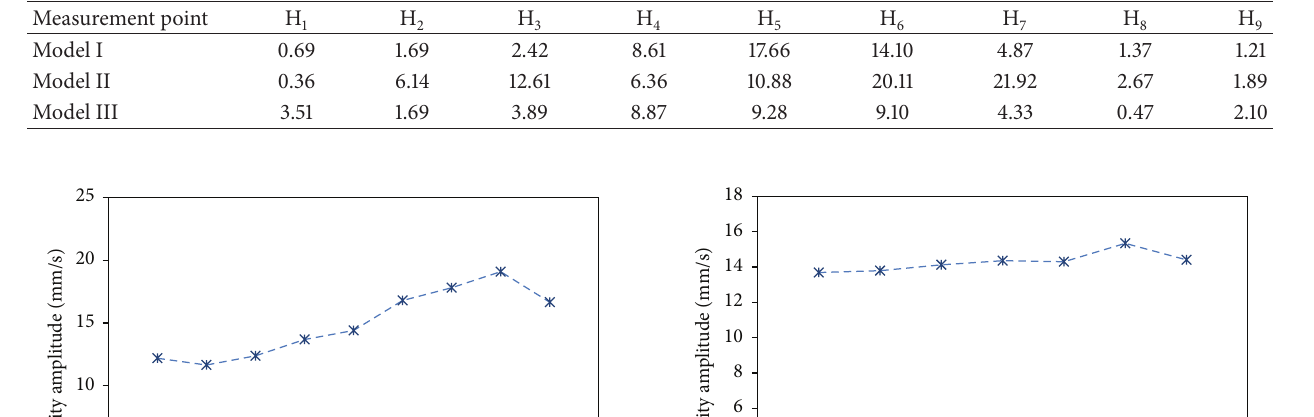
Table 3: Velocity amplitudes at H